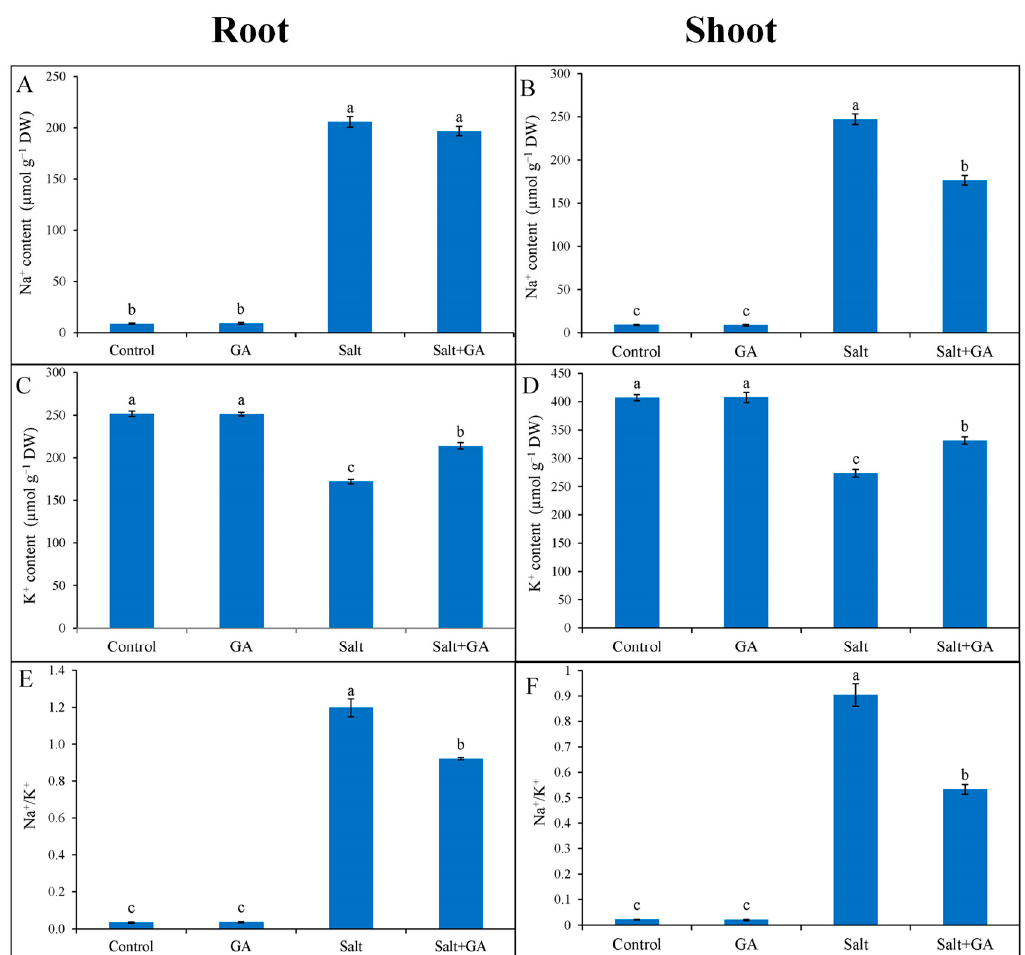
Figure 2. Ion regulation in root ( A,C,E ) and shoot ( B,D,E ) of salt-treated rice ( O. sativa L. cv. BRRI dhan52) seedlings as influenced by GA supplementation. 1 mM gallic acid and 200 mM NaCl are specified by GA and Salt, correspondingly. Values with different letters are significantly different at p ≤ 0.05 applying the Tukey’s HSD test.